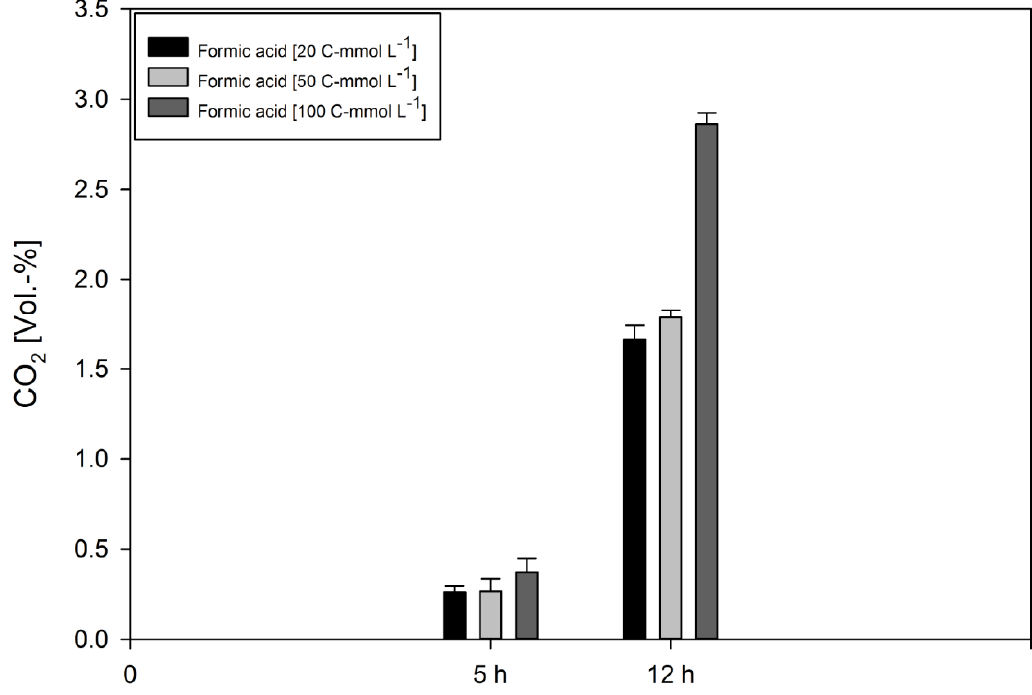
Figure 4. Headspace gas composition of D. amylolyticus , from experiments performed in triplicates, at the end points of the whole cell conversion experiment. The experiment was designed and performed to be able to measure the cumulative gas accumulation in the serum bottle headspace. Despite the application of high cell density in the whole cell conversion experiment no H 2 accumulation was detected.